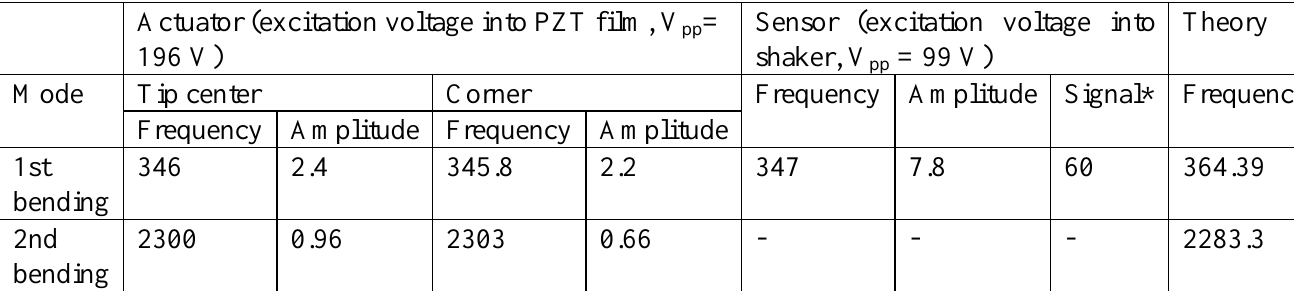
Table 2 . Experimental and theoretical results of the vibration of the cantilever specimen.